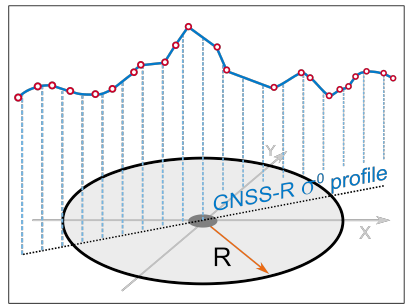
Figure 1. A sketch of the gridded GNSS-Reflectometry profile of Cyclone GNSS (CYGNSS) over an eddy and the local coordinate system with x- and y-axes oriented toward east and north,